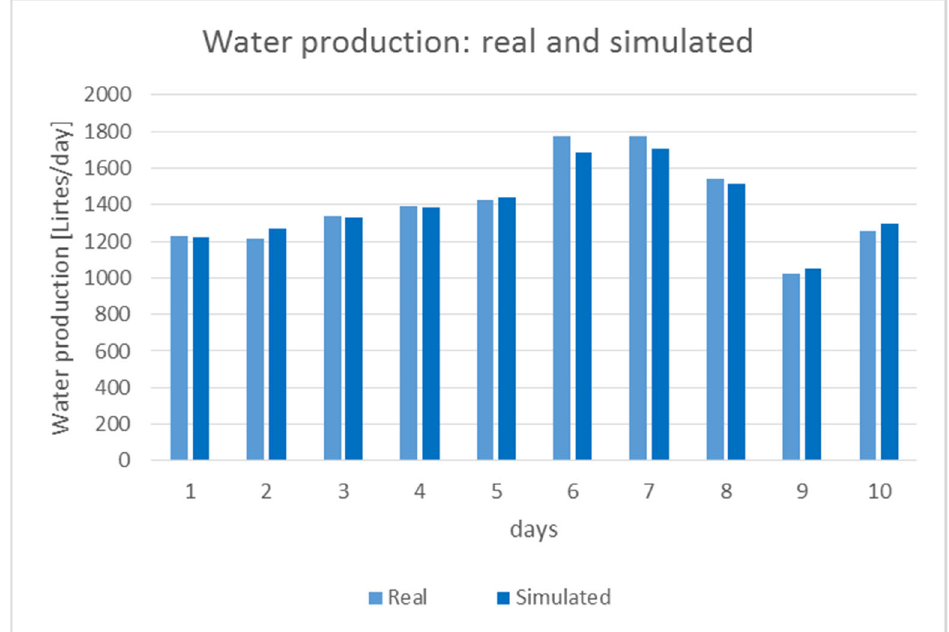
Figure 7. Daily water production: comparison between real and simulated data.